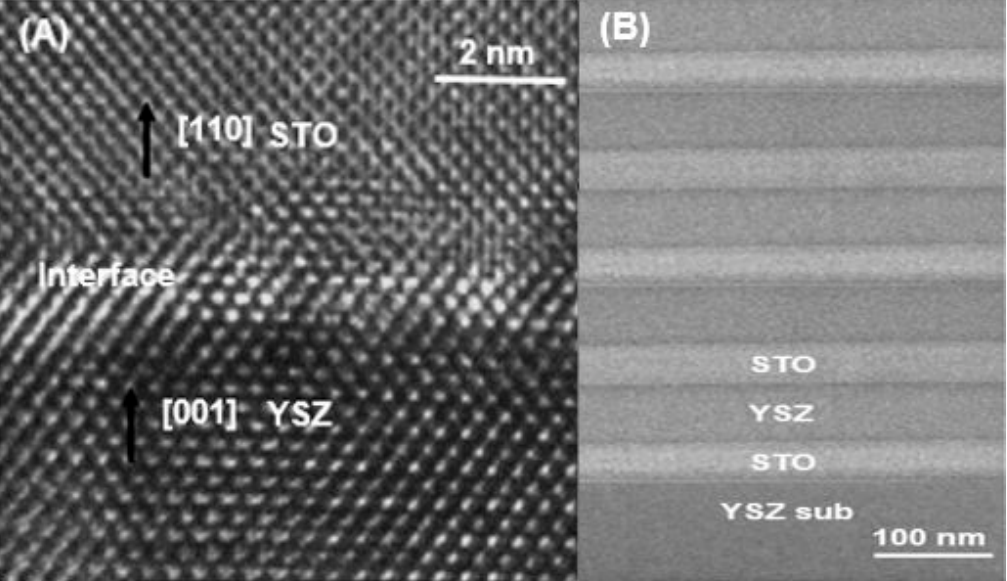
Figure 2. TEM micrograph of the device. ( A ) High-resolution TEM image YSZ/STO thin film, and the interface indicating good crystallinity of the sample; and ( B ) Low-magnification TEM image of cross-section showing the YSZ substrate, five layers of STO thin film (thickness around 50 nm)/YSZ thin film (thickness around 100 nm).